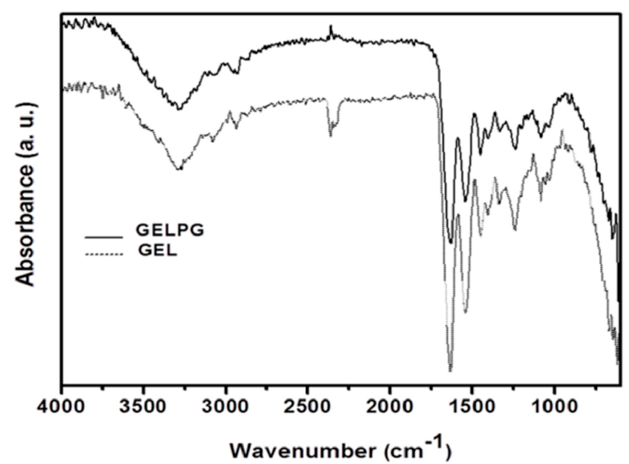
Figure 4. FTIR spectra of the GEL (dash line) and GELPG membranes (solid line).